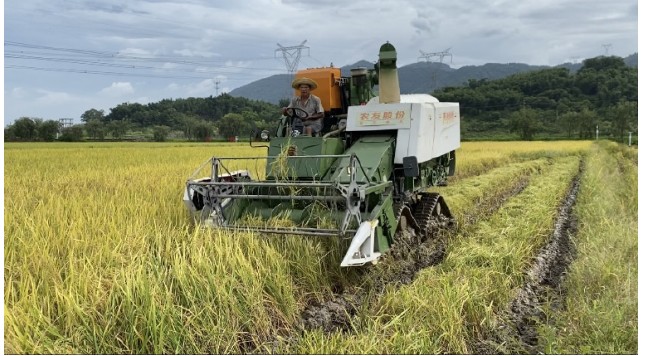
Figure 12. Field